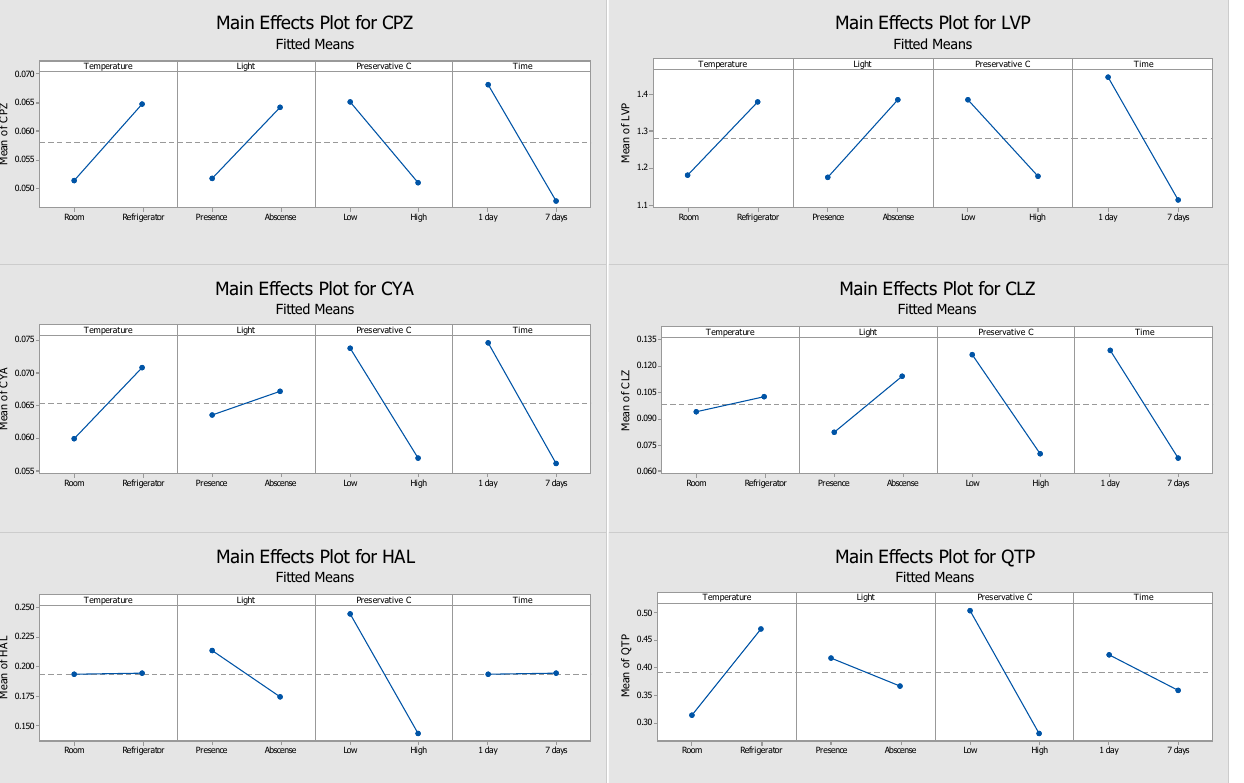
Figure 4. Main effects plots from sodium fluoride used as the preservative, which demonstrates the main factors in each parameter of each analyte (CPZ—chlorpromazine, LVP—levomepromazine, CYA—cyamemazine, CLZ—clozapine, HAL—haloperidol, QTP—quetiapine). The slope of the lines represents the effect of the response for the factors under study: temperature (25 ◦ C or 4 ◦ C), light (presence or absence), preservative concentration level (low or high), and storage time (1 or 7